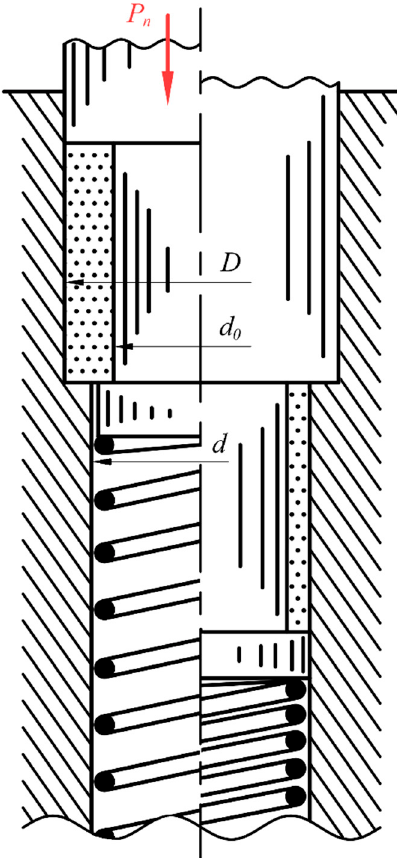
Figure 7. The scheme of the method for applying graphite coating to the sintered preform prior to extrusion, where P n —specific power applied to the punch; D —diameter of larger die cavity; d 0 —diameter of preform; d —diameter of main die cavity.